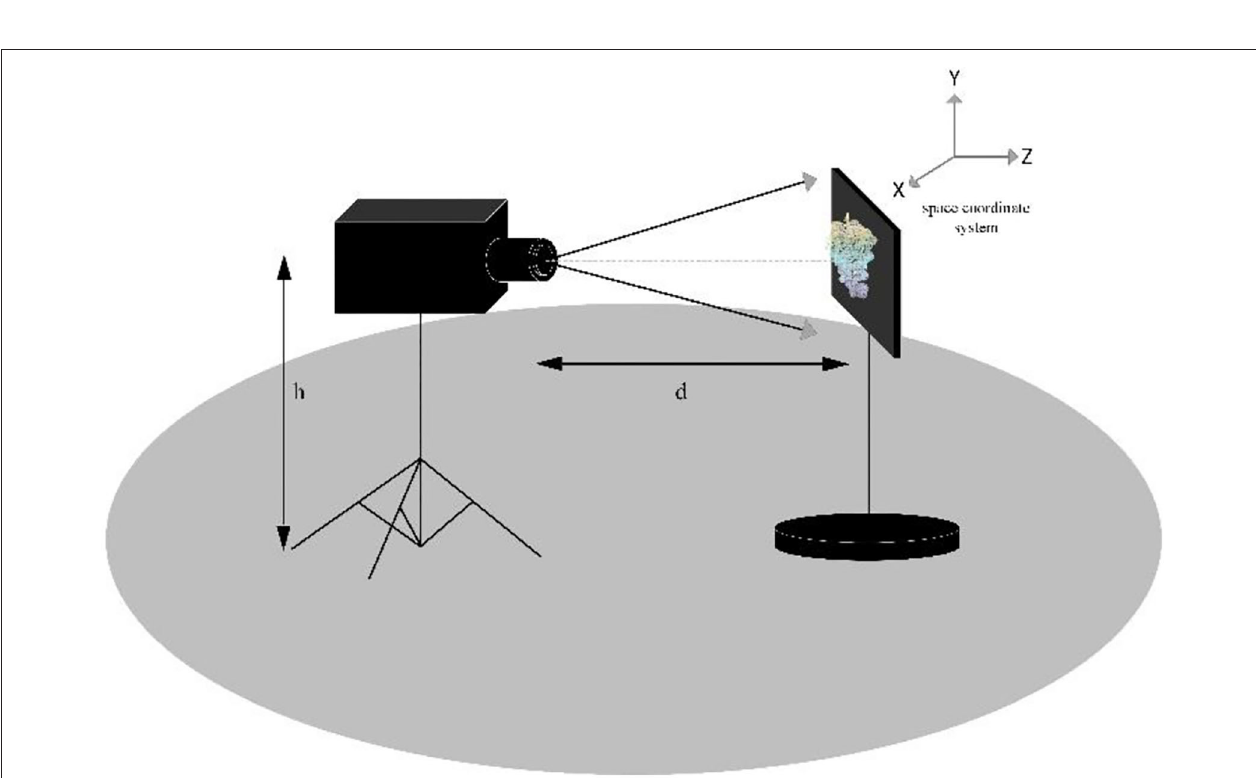
FIGURE 1 | Red grape map.